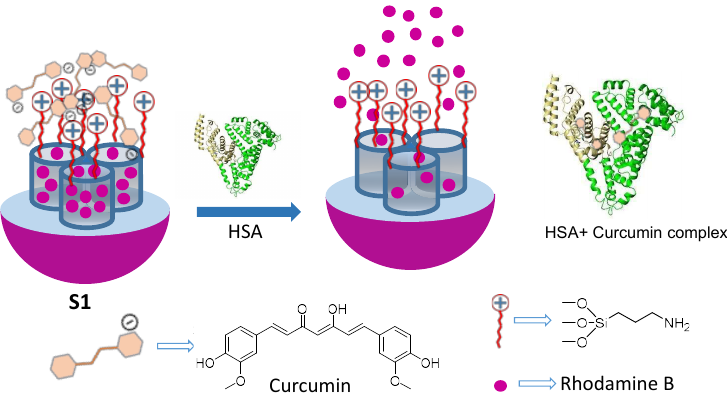
Scheme 1. Schematic representation of the sensing mechanism of S1 nanoparticles in the presence of HSA.